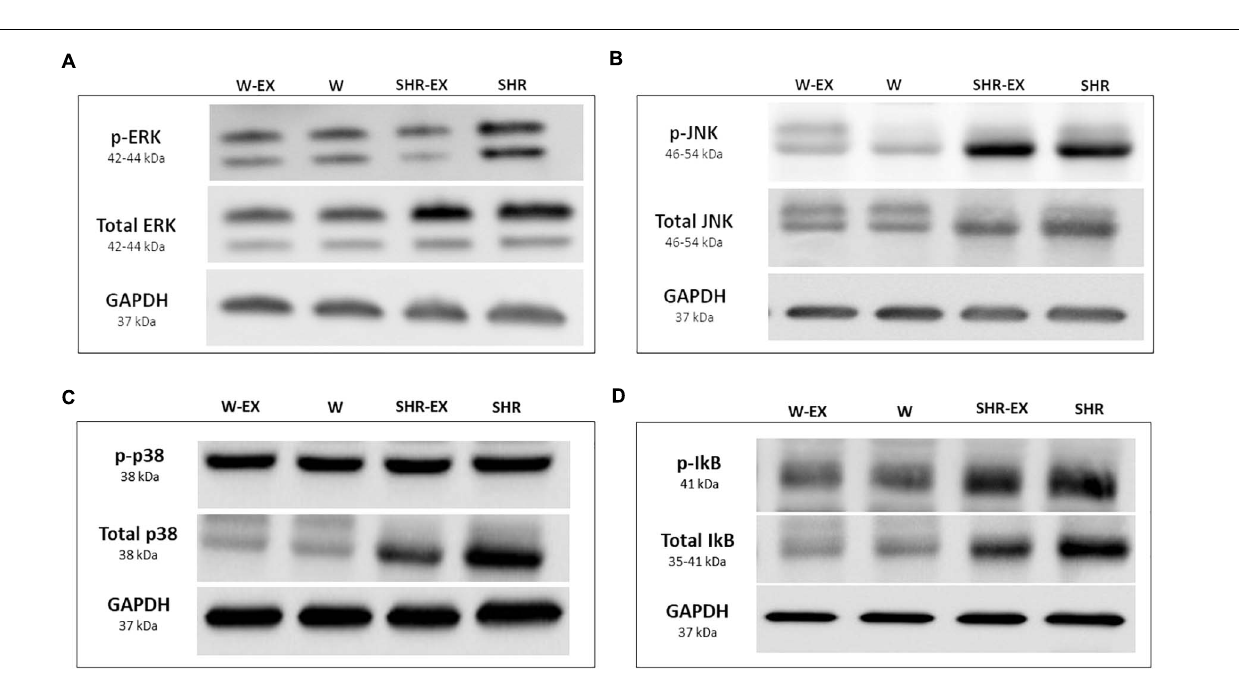
Frontiers in Physiology |